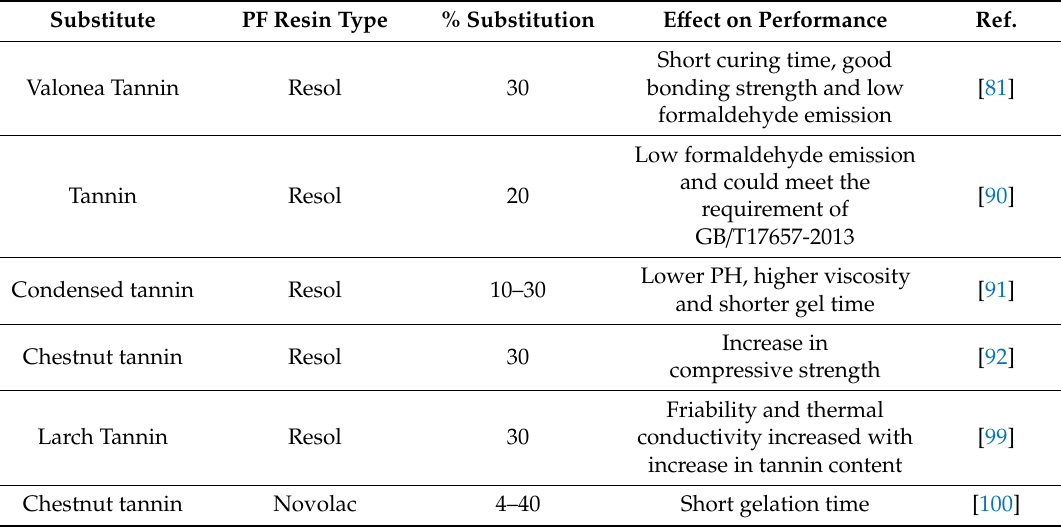
Table 2. Examples of tannin substituted phenolic